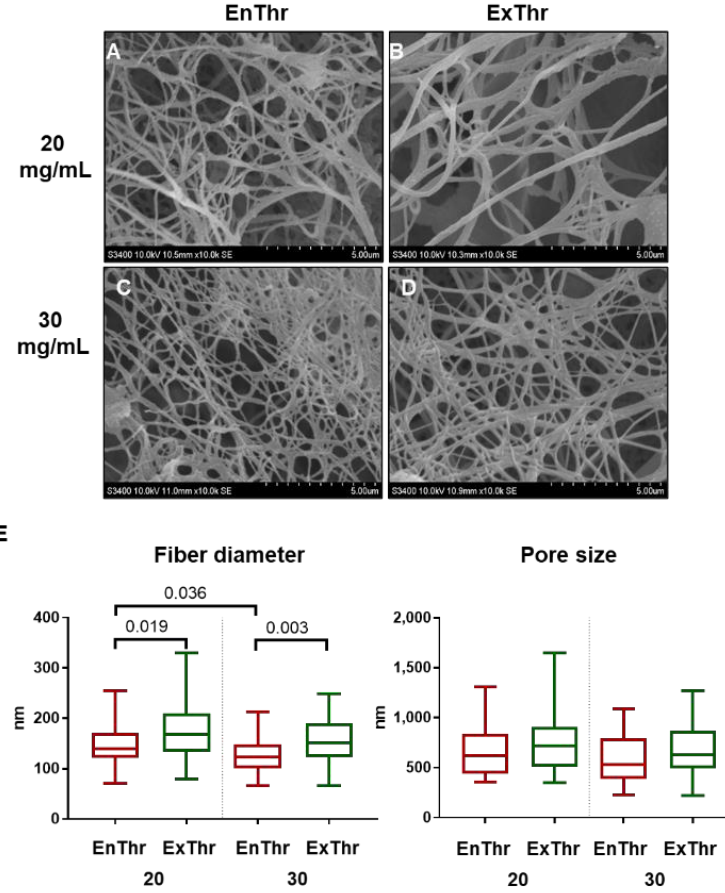
Figure 1. Microstructure of fibrin matrices prepared at fibrinogen concentrations of 20 and 30 mg/mL using endogenous (EnThr) and exogenous (ExThr) thrombin: ( A – D ) scanning electron microscopy of fibrin matrix surface, × 10,000 magnification; ( E ) quantification analysis of fiber diameter and pore size, center lines indicate the median, box boundaries indicate the 25th and 75th percentiles and whiskers indicate range.